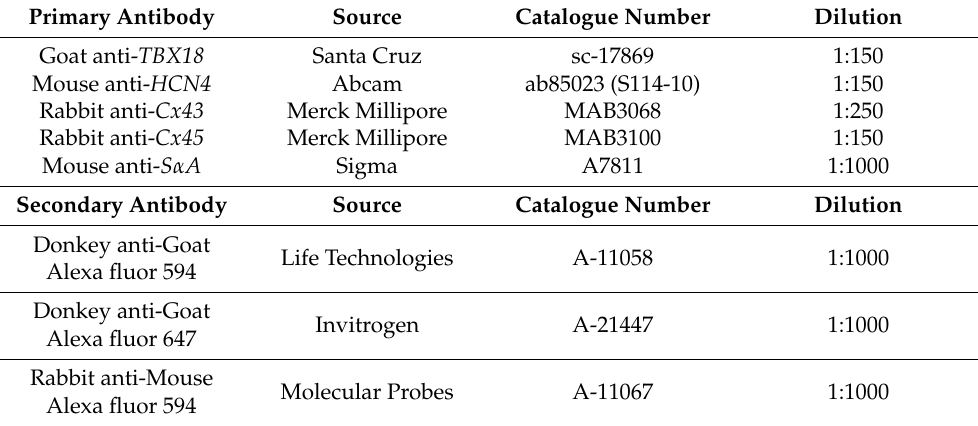
Table 3. Primary and secondary antibodies used in the immunocytochemistry